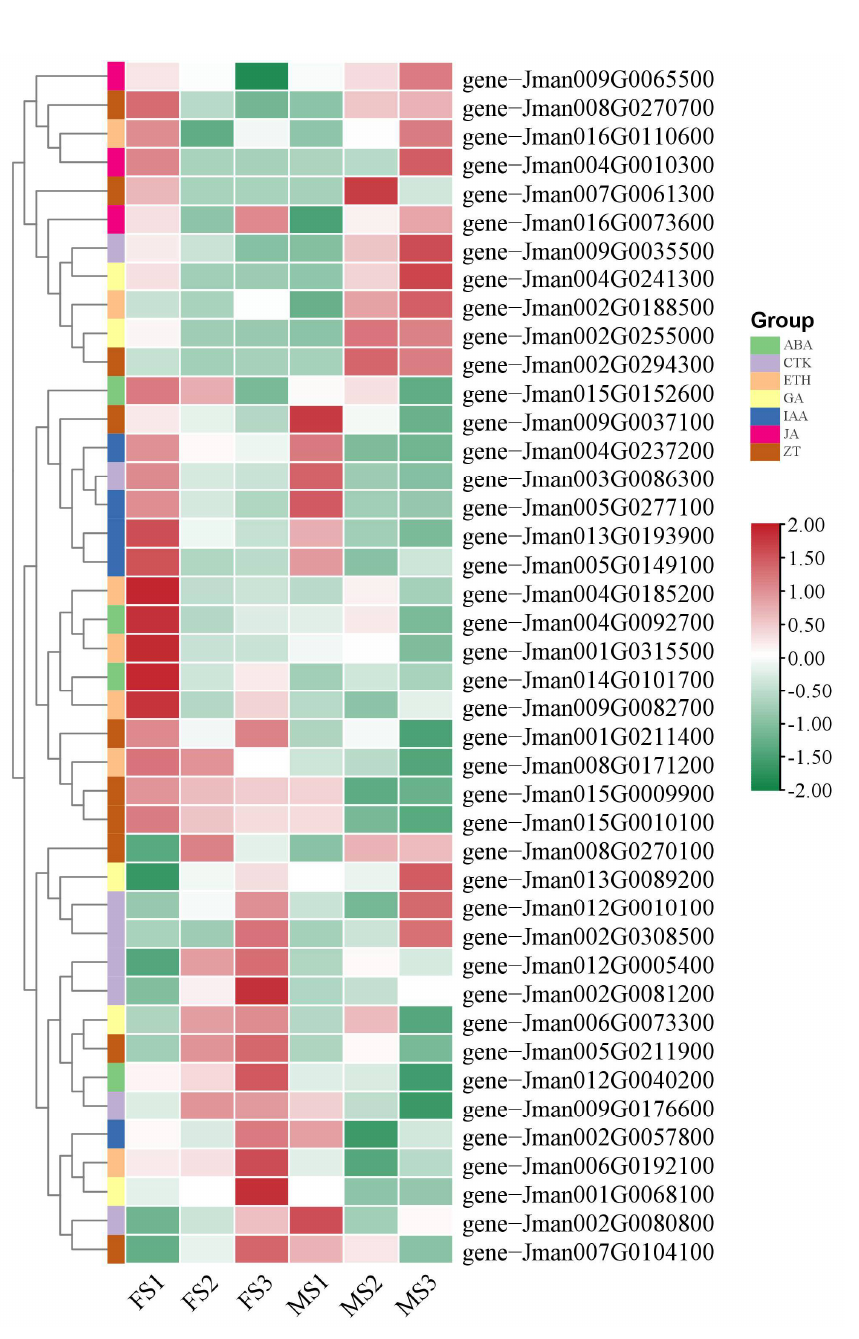
Figure 7. Identification and expression analysis of phytohormone during flower development. The color scale from green to red indicates the expression value from low to